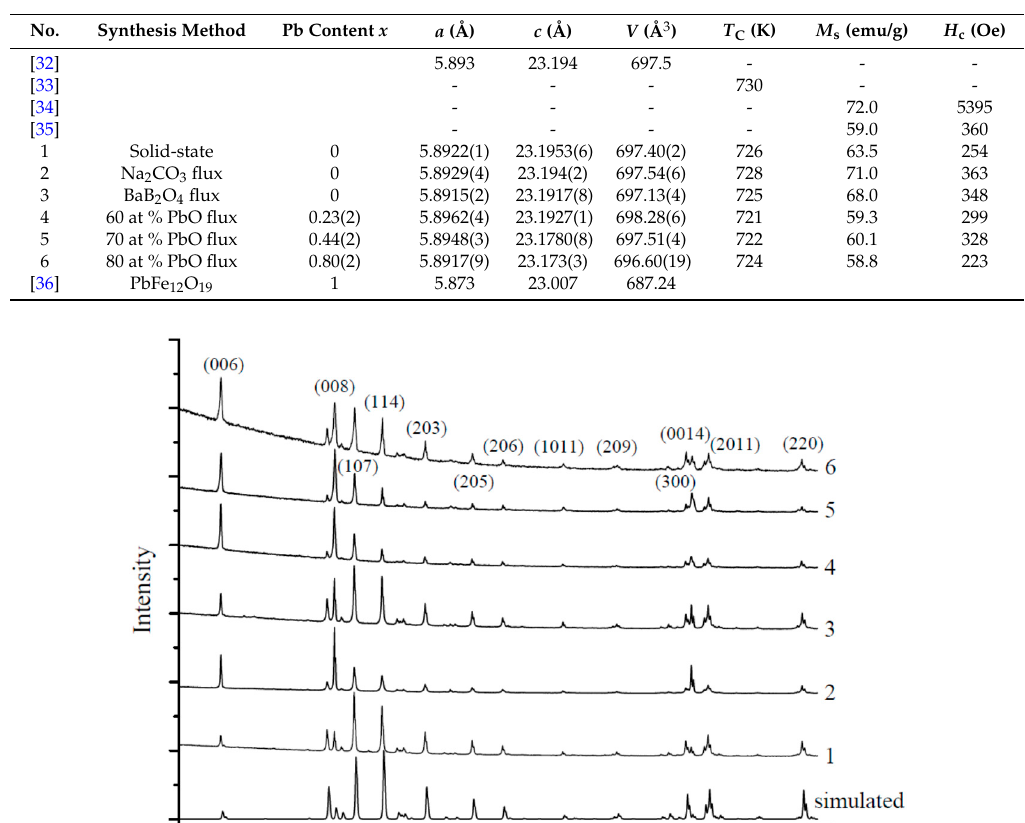
Table 2. Unit cell parameters from PXRD, Curie temperature, and saturation magnetization values of powder samples of barium hexaferrite.